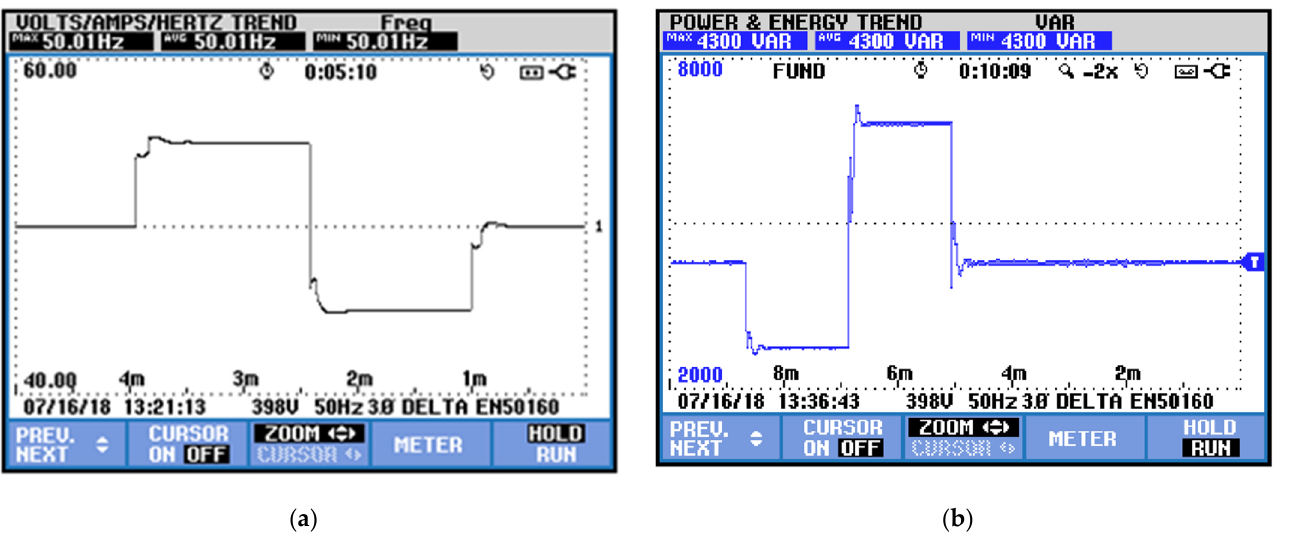
Figure 15. ( a ) Frequency Result—45, 50, and 55 Hz variation; ( b ) Reactive Power result for 45, 50, and 55 Hz frequency variation.